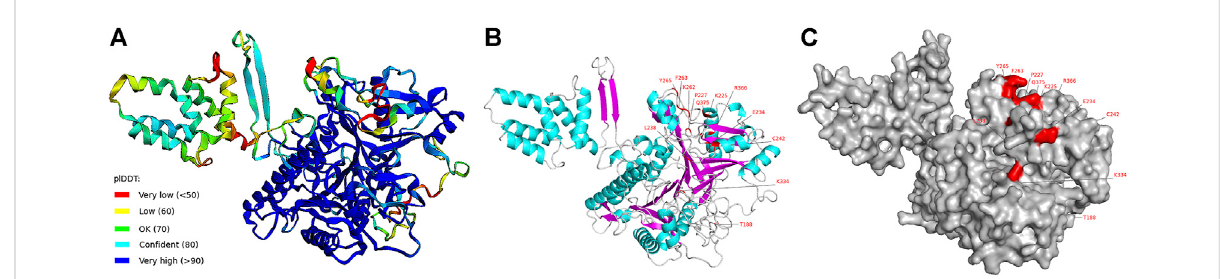
FIGURE 8 Three-dimensional structure of PLD11 predicted by AlphaFold. (A) Schematic diagram of 3D structure of PpPLD11 colored bythe pLDDT score. (B) View of positively selected amino acid sites on the 3D structure of PpPLD11. Helix, sheet, and loop are represented by cyan, magenta, and light grey, respectively. (C) View of positively selected amino acid sites on the surface of PpPLD11. The positively selected sites are colored in